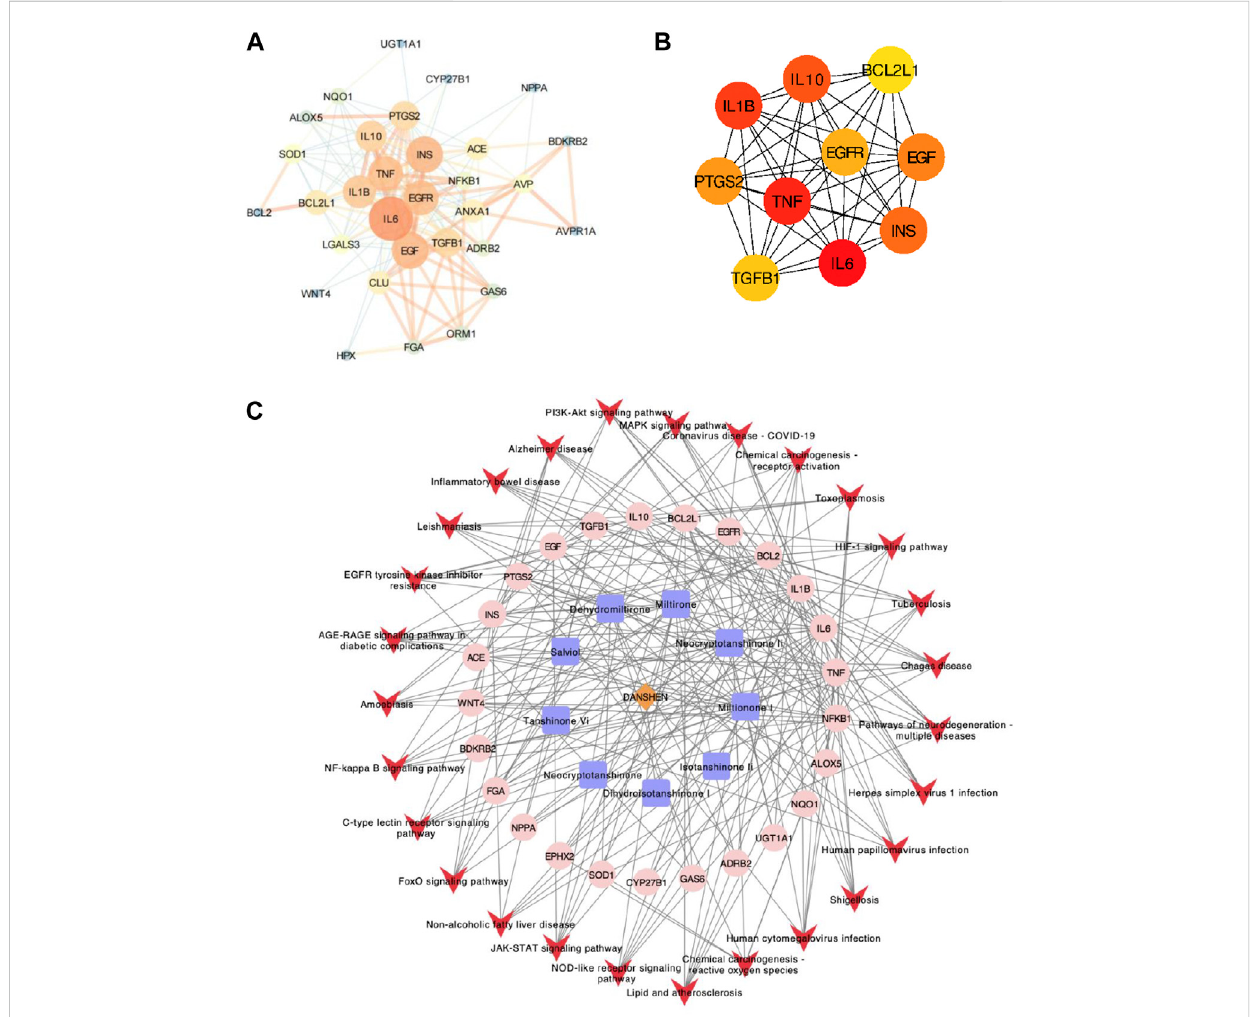
(Figure 3B), and miltirone I – IL-6 (Figure 3C). The molecular docking results suggested that DHT and COX2 have the highest af fi nity score (Supplementary Table